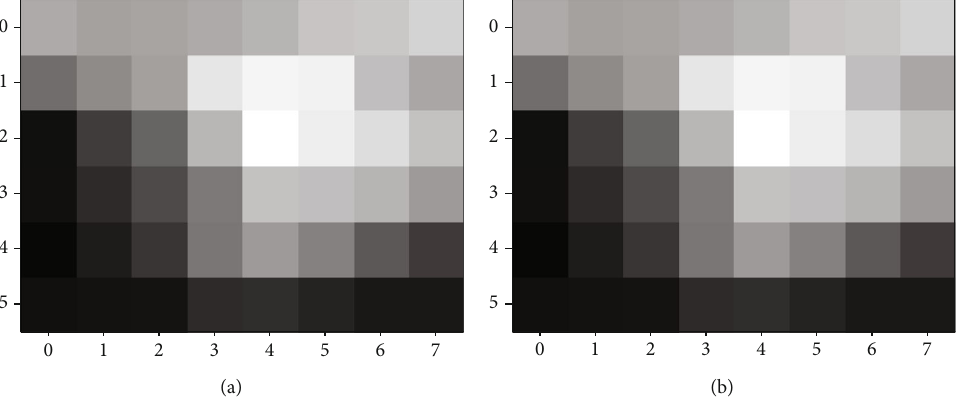
Figure 3: (a) The original 8 × 6 grayscale image selected by the server and (b) its modi fi ed version — the LSBs of the upper-left and lower- right pixels are set to 0. The di ff erences between the two are hardly noticeable.